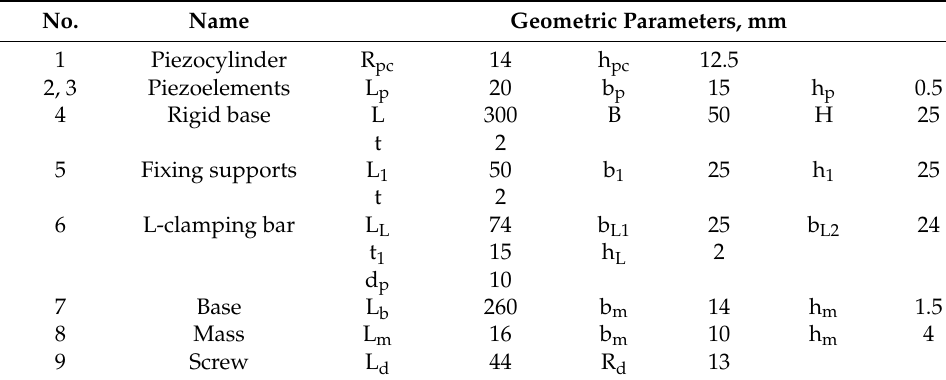
Table 1. Geometric characteristics of the dimensions of PEG elements.